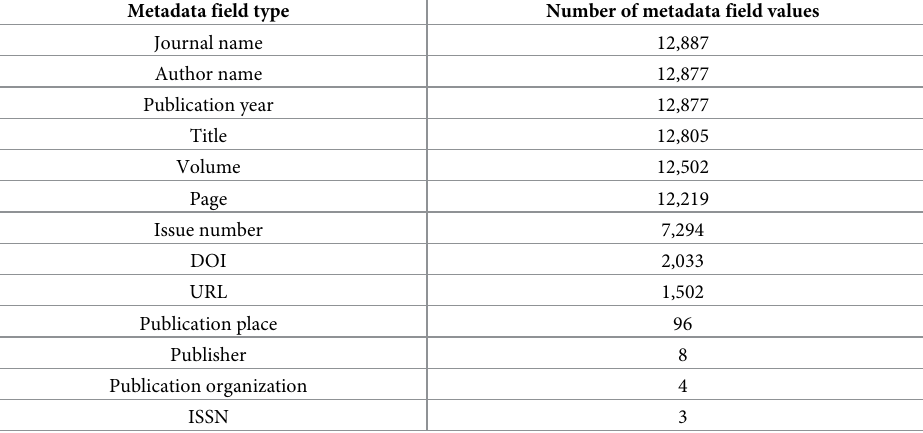
Table 9. Number of metadata field values in 12,887 new